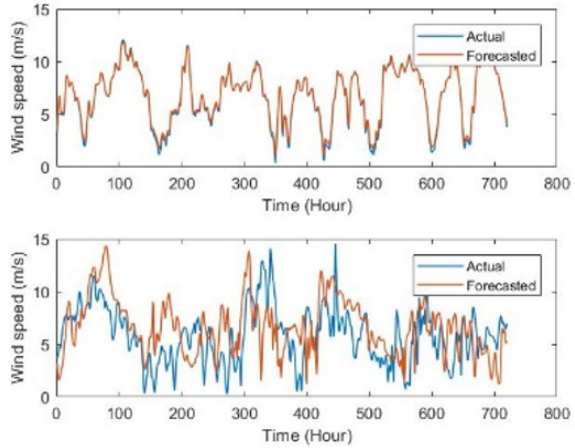
Figure 19. Forecasted and actual wind speeds of 2017, Jan & Feb, Dhahran, Case III.